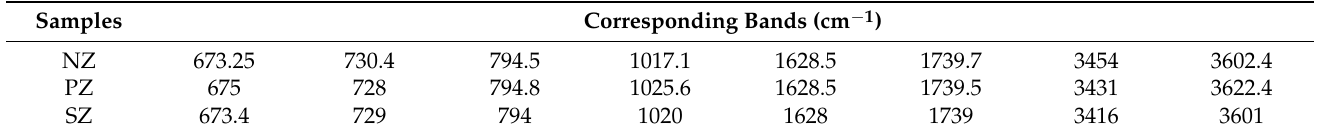
Table 3. The corresponding bands of the FTIR spectra for NZ, PZ, and SZ.